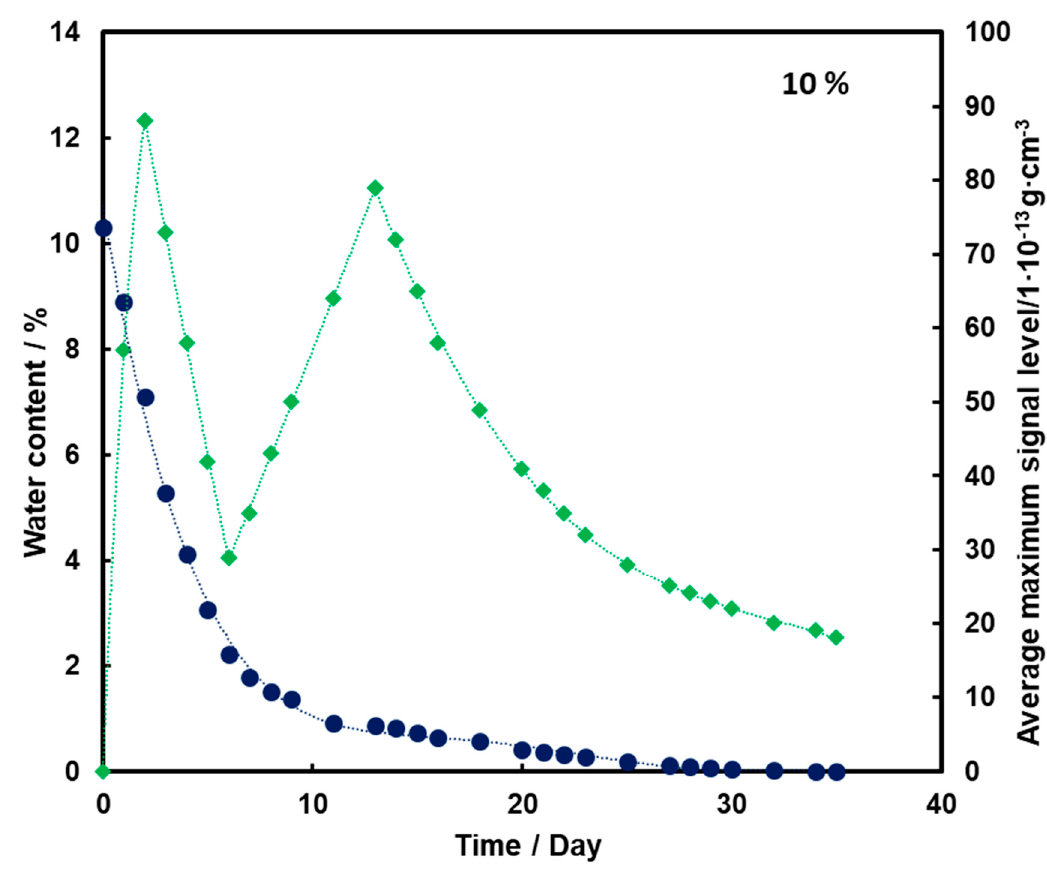
Figure 4. Dependence of the mean maximum TNT signal ( ♦ ) on the amount of water ( ● ) in time for a substrate with a humidity of 10%.